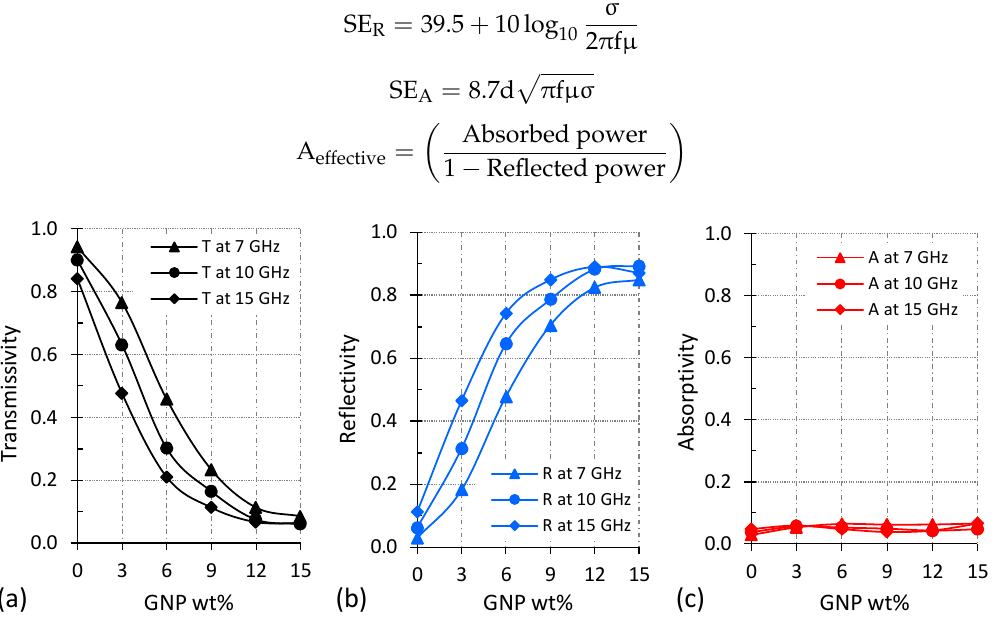
Figure 6. Variations of the ( a ) transmissivity, ( b ) reflectivity, and ( c ) absorptivity of PBAT/GNP nanocomposites with GNP concentration at different frequencies.